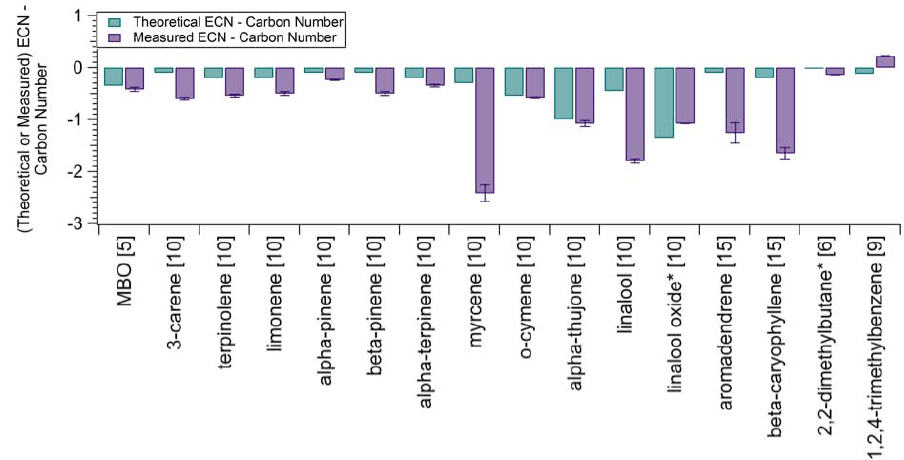
Fig. 4. A comparison of the carbon number difference for theoretical vs. measured ECN values for all the gas standards generated with the dynamic dilution system. The carbon number is shown in brackets after the compound name along the bottom axis. Error bars represent one standard deviation from the average value. *Standard deviations for linalool oxide and 2,2-dimethylbutane were 0.002 and 0.0008, respectively, and are too small to be seen on this